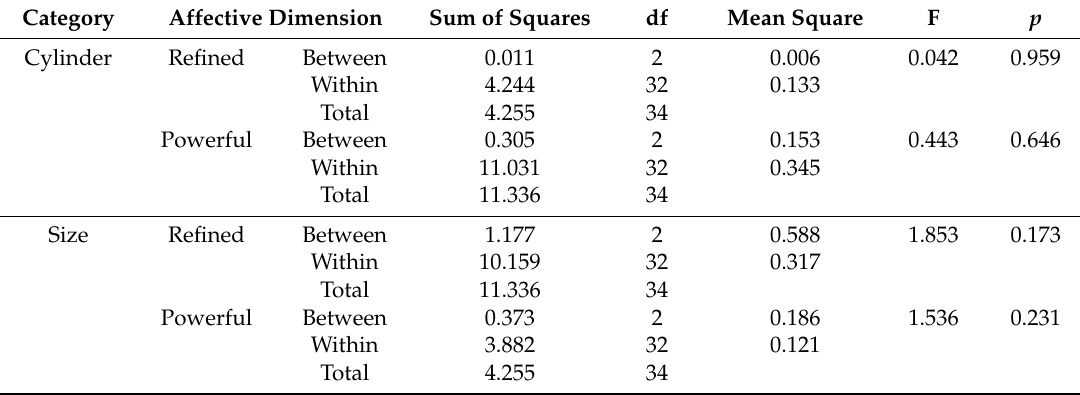
Table 6. Results of ANOVA for extracting representative affective dimensions in engine sound.